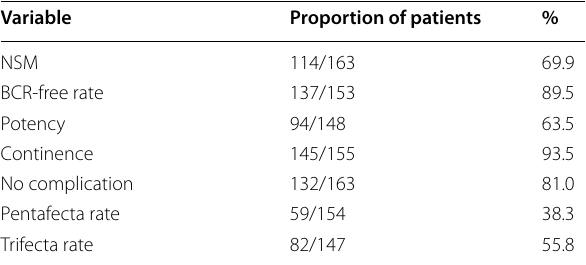
Table 2 Variable comprising the pentafecta